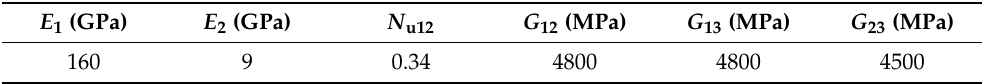
Table 1. Material properties of CFRP